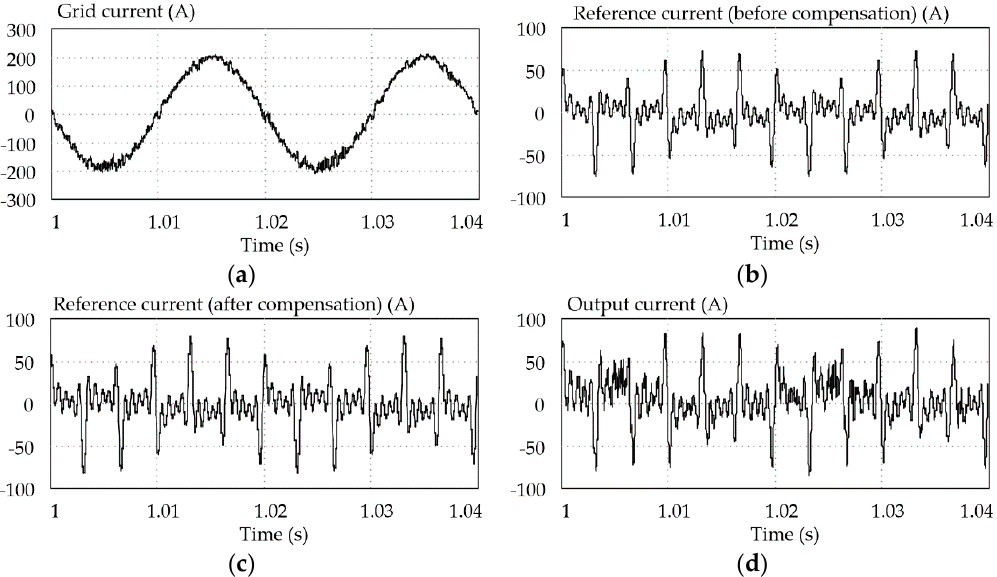
Figure 11. Simulation result with reference compensation. ( a ) grid current; ( b ) reference current (before compensation); ( c ) reference current (after compensation); ( d ) output current.